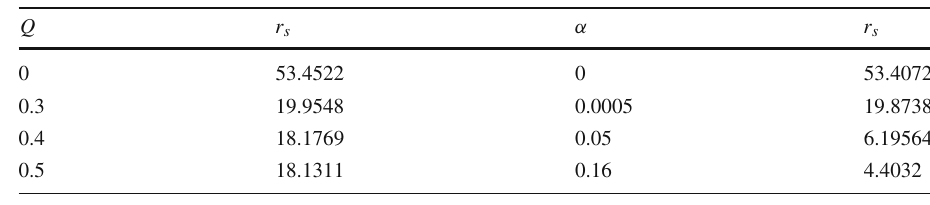
Table 6 Static radius for ω = − 1